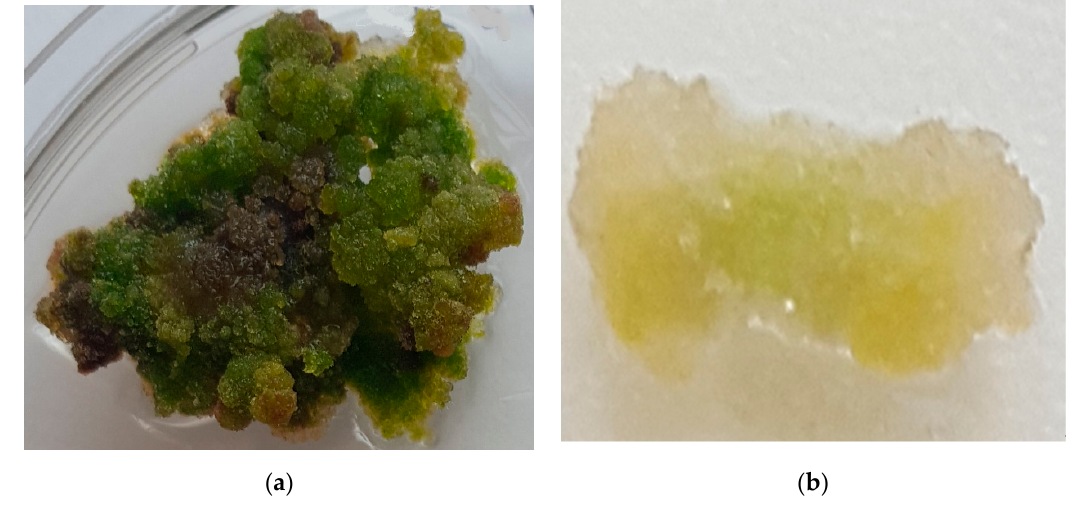
Figure 1. Callus from ( a ) leaf (bar = 2.0 mm) and ( b ) stem segment (bar = 1.0 mm) explants.